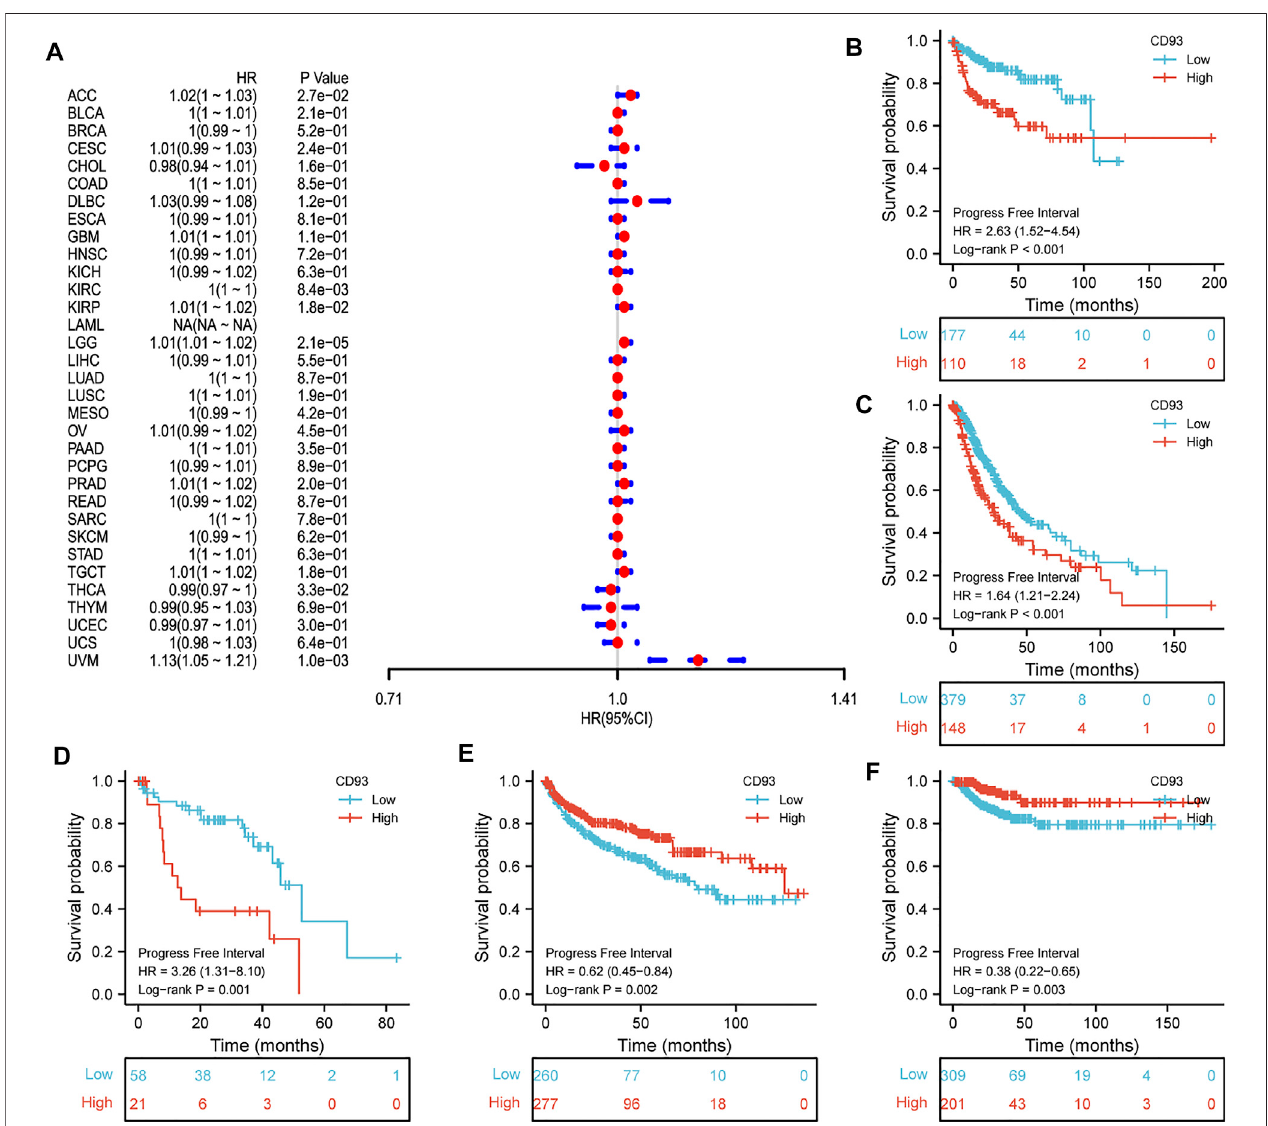
FIGURE 4 | Association between CD93 expression and PFI. (A) Forest plot of PFI associations in 33 types of tumors. (B – F) Kaplan – Meier analysis of the association between the CD93 expression and PFI in KIRP, LGG, UVM, KIRC, and THCA.